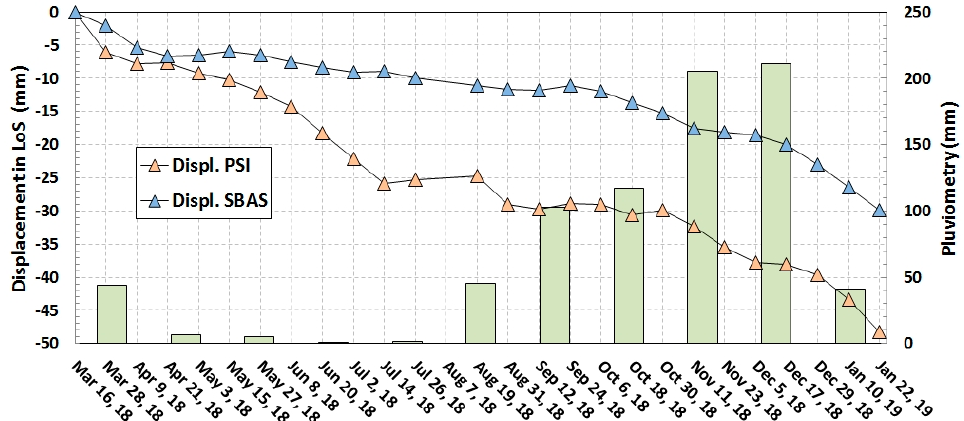
Figure 16. Time-series of LoS displacement for two selected points located at the bottom of the dam showing the maximum cumulative displacements for the entire monitoring period and the accumulated pluviometric data.